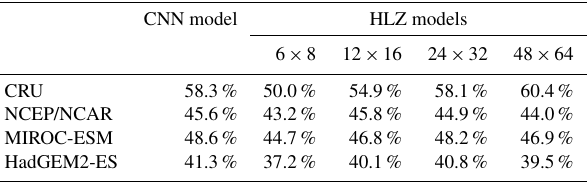
cal (0.701–0.734), compared to when these datasets were dif- Table 2. CNN model and HLZ models accuracies for biome dis- tribution simulations. CNN model corresponds to the top row model of Table S2 (a RGB colour tile). Four HLZ models have different bin sizes for climate classifications (bio-temperature class × precipitation class). Each model was trained with the CRU dataset and adapted to the all-climate datasets (i.e. agreements of the CRU dataset correspond to the training accuracy, while other climate data correspond to the test accuracy). In addition, for each climate dataset, the annual mean bio-temperature and annual pre- cipitation from 1971 to 1980 were log transformed before